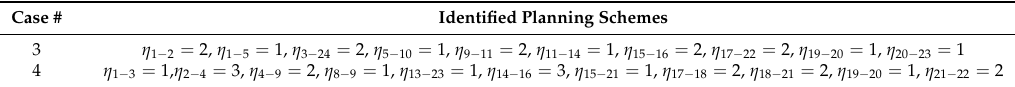
Figure 6. Tradeoffs between cost and risk for cases 3 and 4 for IEEE 24-bus system. Table 4. Planning results for cases 3 and 4.